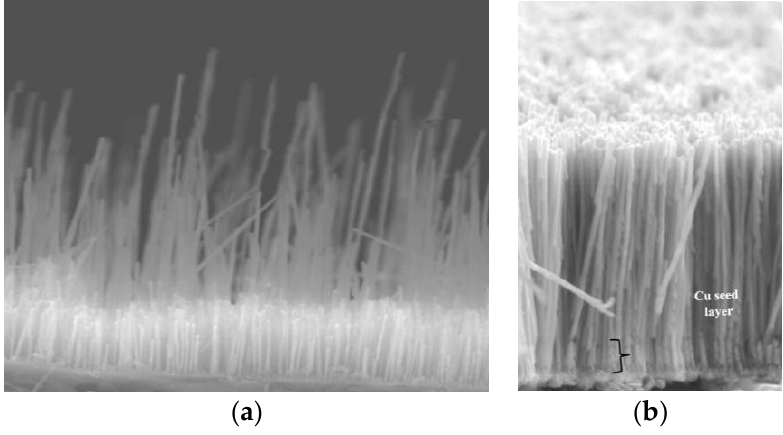
Figure 9. ( a ) A second problem unique to Galfenol was extremely inhomogeneous lengths, where many short nanowires (~4 μm) were seen at the growth electrode while others grew extremely fast, even to the top of the template. ( b ) Uniform lengths (8 μm ± 3%) were achieved using a rotating disk electrode, a Cu seed layer, and pulsed deposition [20].